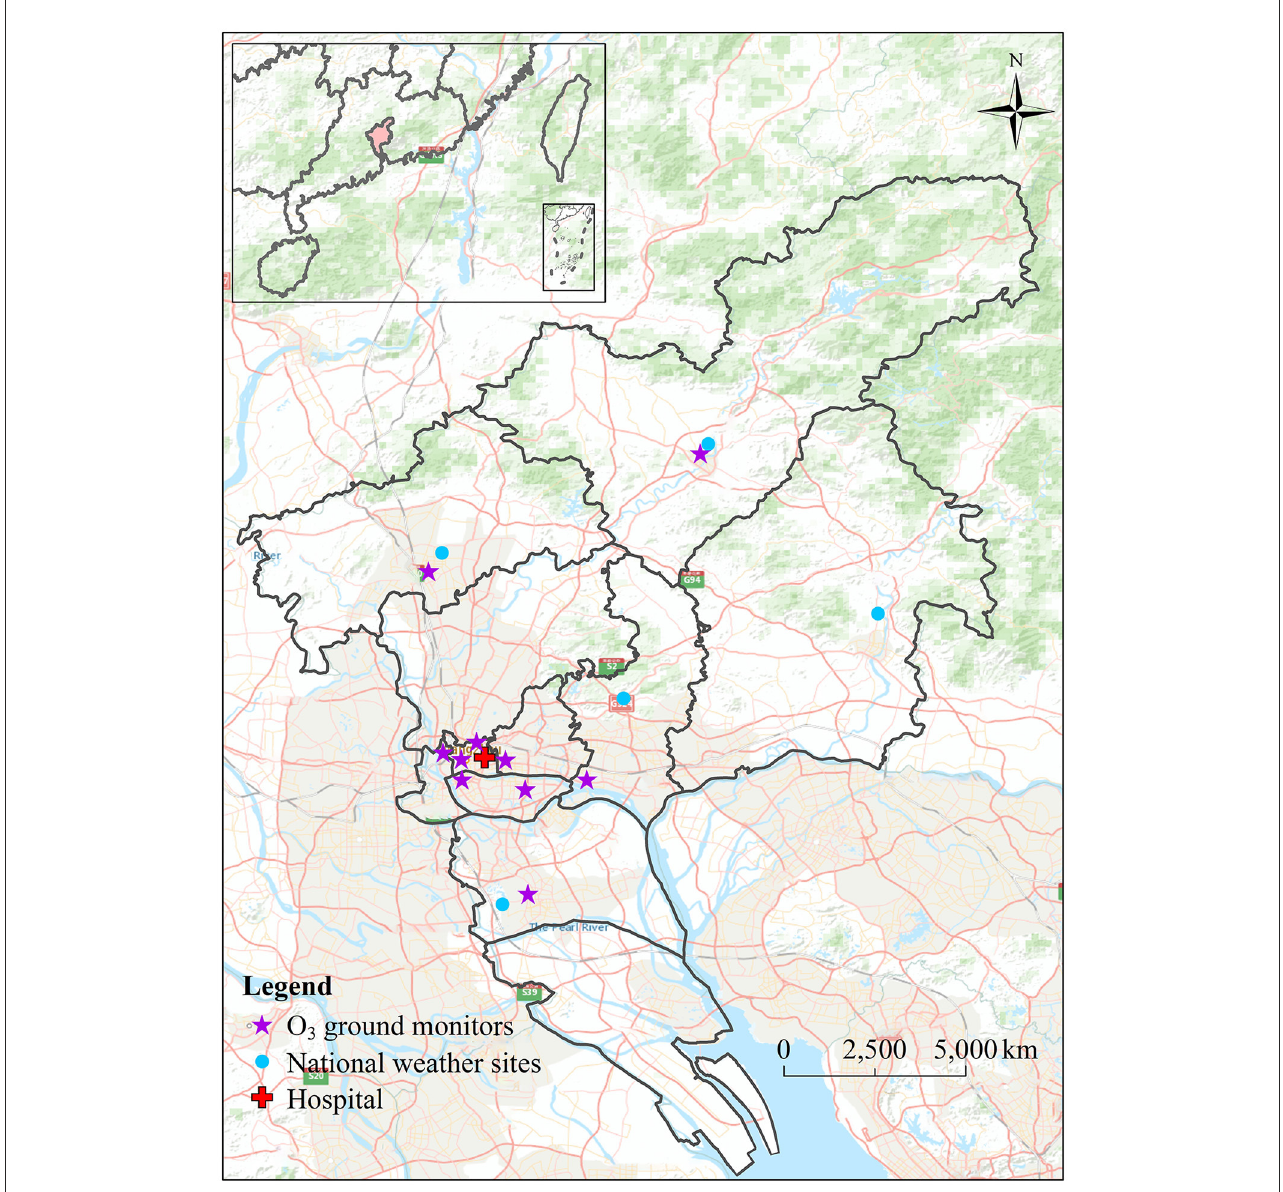
FIGURE1 The spatial distribution of air quality monitoring stations, weather sites, and targeted hospital in